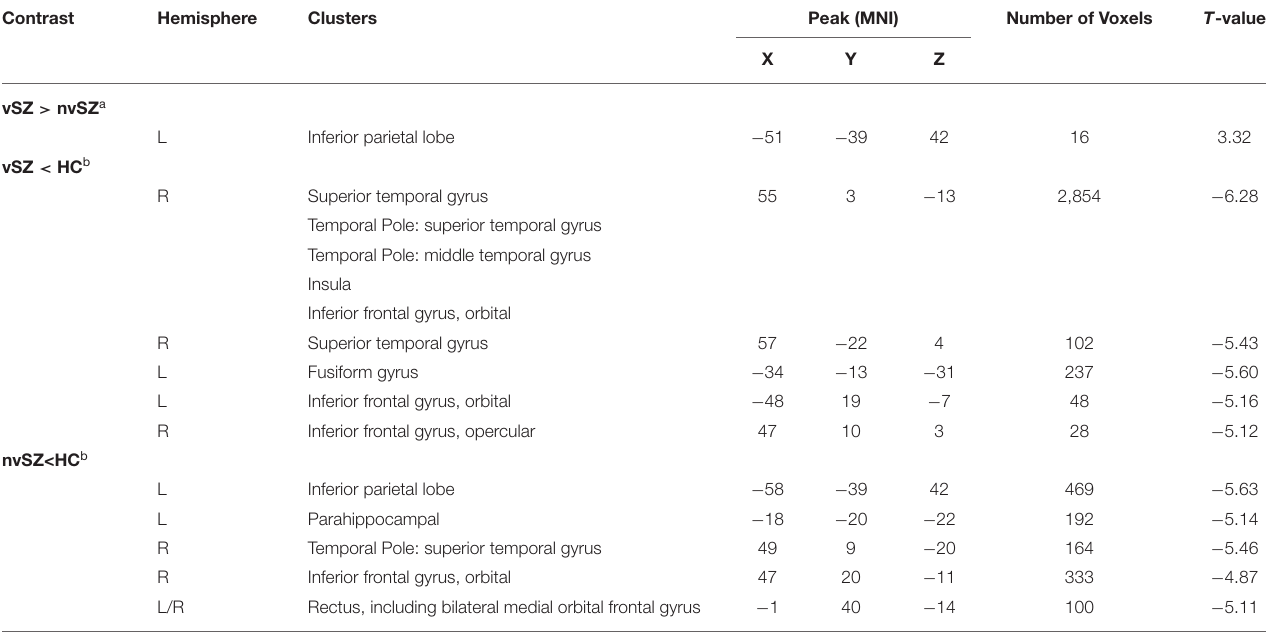
TABLE 2 | Significant differences in GMV in pairwise comparisons. Contrast Hemisphere Clusters Peak (MNI) Number of Voxels T -value